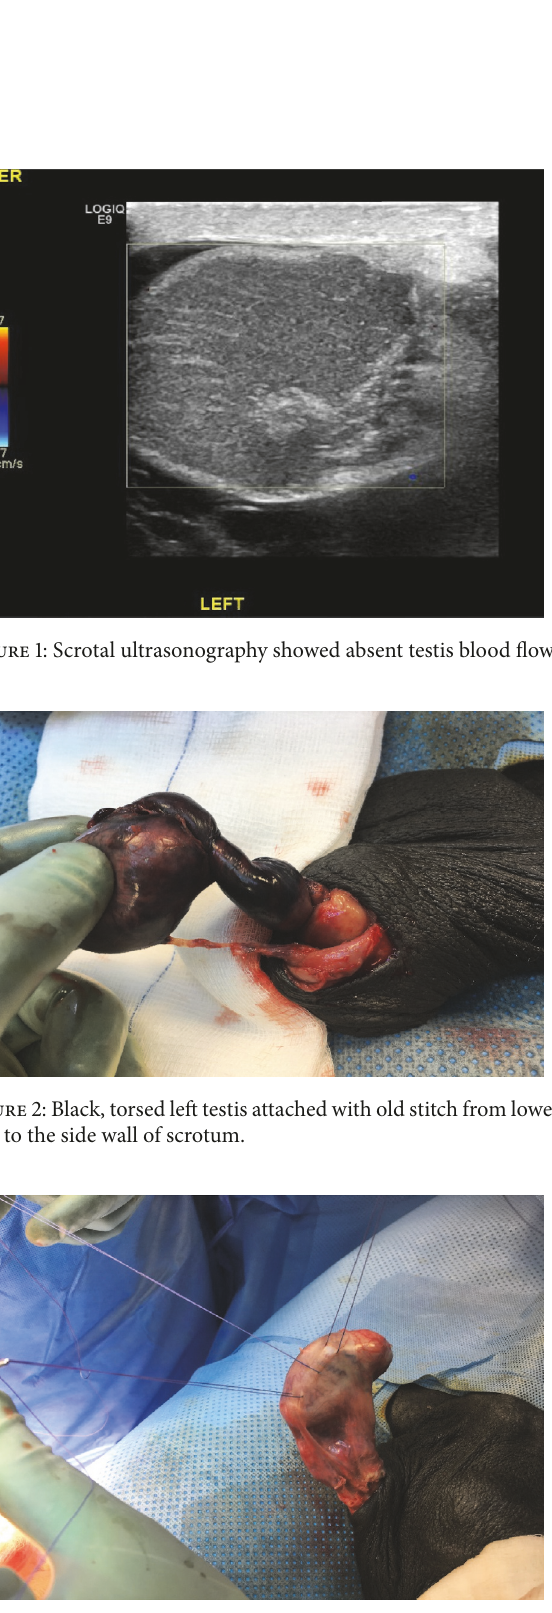
Figure 3: Fixation of the right testis with three